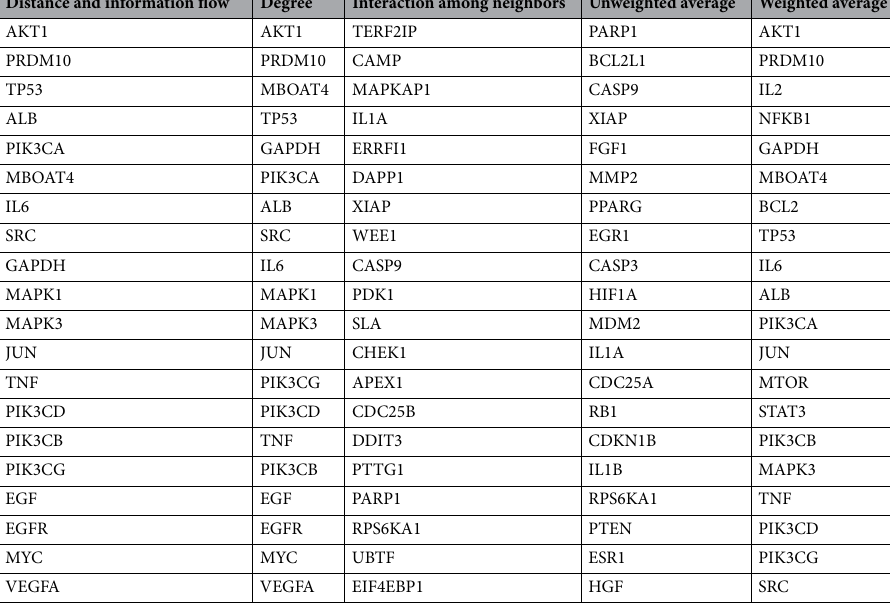
Table 2. Weighted and unweighted averages of proteins rank after categorizing centrality indices in three groups, as mentioned in